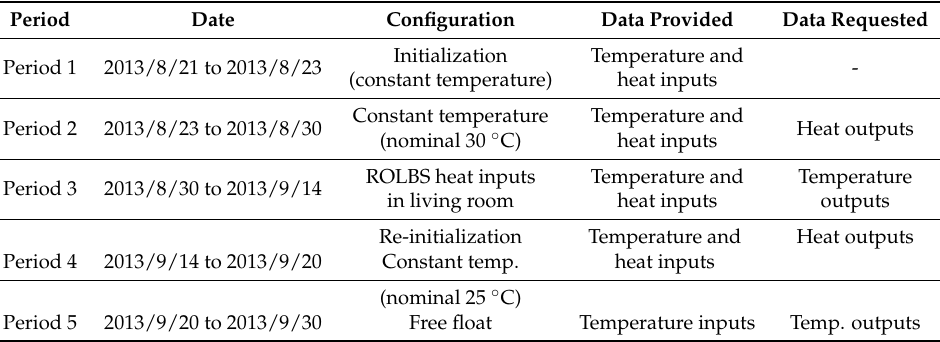
Table 2. Data periods, data provided, and data